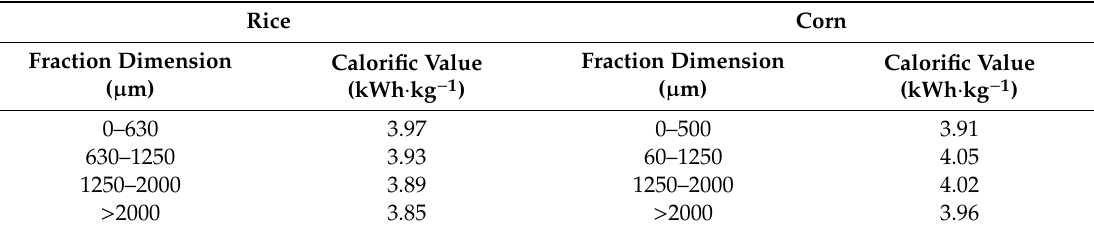
Table 6. Calorific values of selected fractions of rice and corn calculated based on [55].